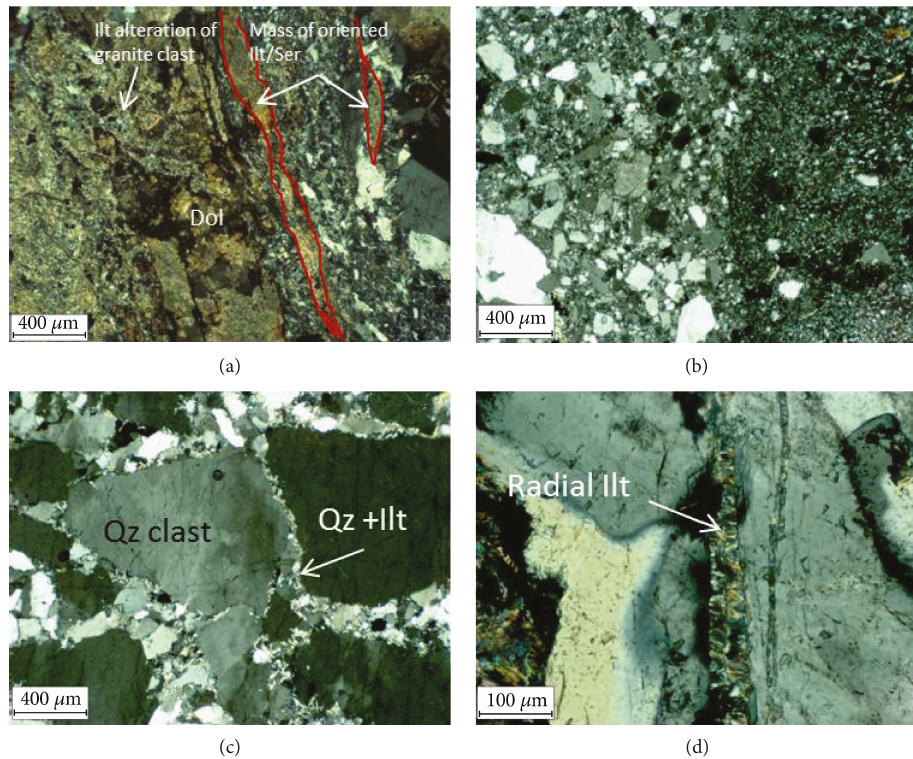
Figure 10: Microphotographs in polarized light of di ff erent types of fractures a ff ecting granites on the fl ank of the Rhine Graben (images modi fi ed from [119]): (a) shear/cataclasis with sericite mass/granite clasts in a NW-SE fracture (Waldhambach); (b) cataclastic texture in a E-W fracture (Saint Pierre Bois); (c) protocataclasis of a N50 ° E quartz vein crosscutting Wintzenheim granite; (d) N170 ° E fi ssure fi lled with radial illite and crosscutting the Metzeral